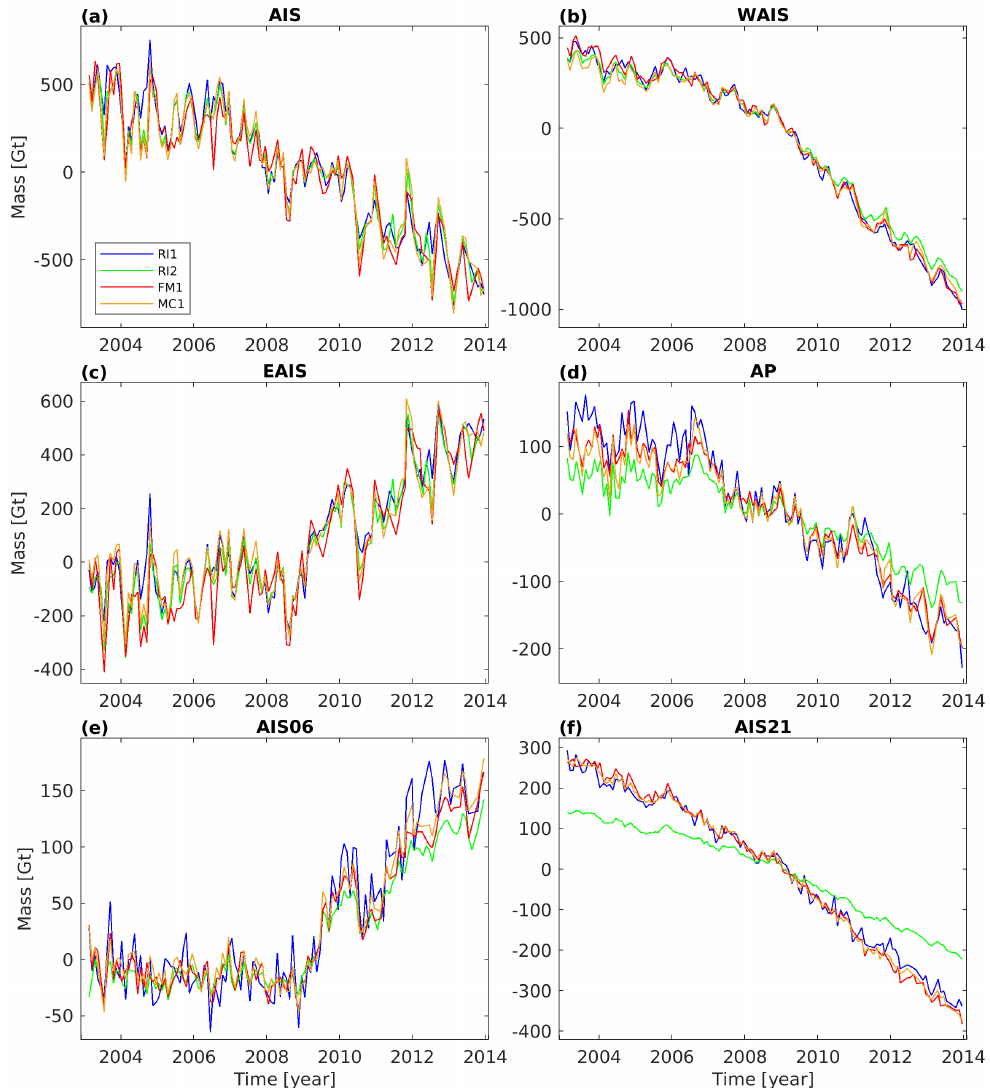
Figure 3. GRACE-derived mass change time series for ( a ) the entire Antarctic Ice Sheet (AIS), ( b ) West Antarctica (WAIS), ( c ) East Antarctica (EAIS), ( d ) the Antarctic Peninsula (AP) as well as the drainage basins ( e ) AIS06 (part of Dronning Maud Land) and ( f ) AIS21 (part of the Amundsen Sea Sector). Figure 1 gives an overview of all drainage basins. The colour coding indicates the results from different groups (Table